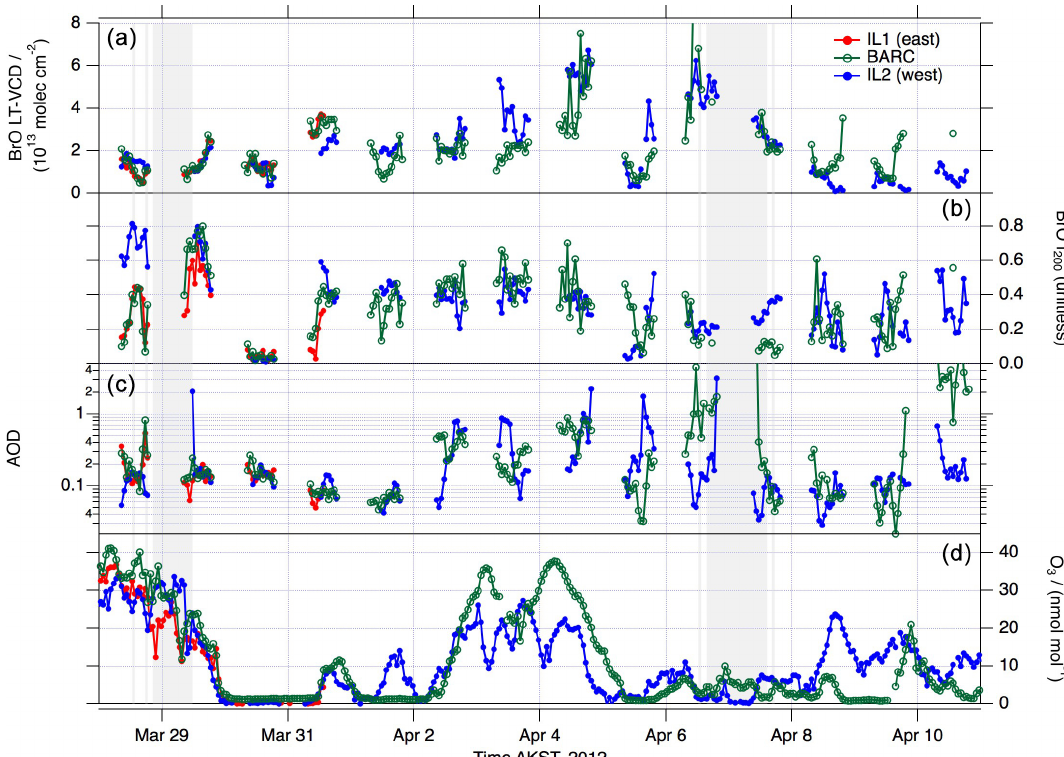
Figure 6. The same as in Fig. 4 but for period B3. IL1 was recovered to BARC on 27 March, was co-located with the BARC instrument during this period, and was shut down at the end of